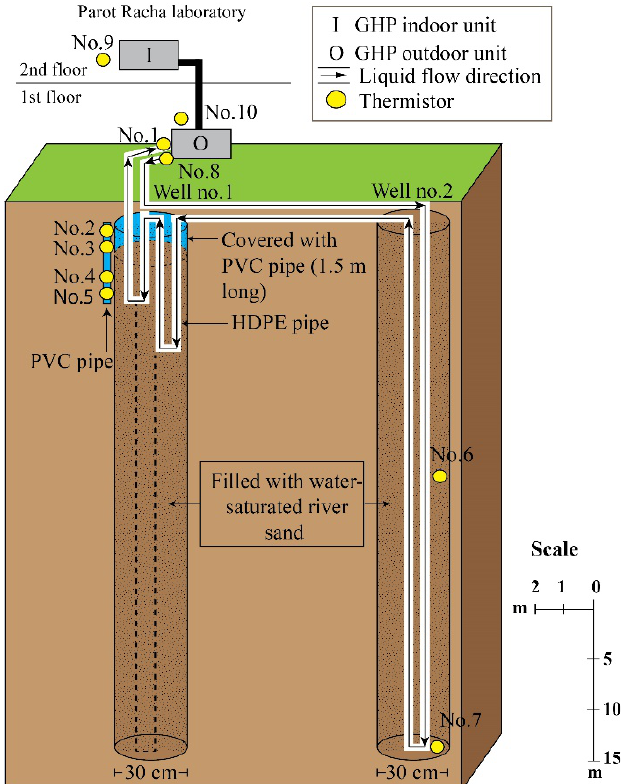
Figure 5. Schematic installation of geothermal heat pump system at Parot Racha laboratory room. Note: HDPE pipe in well no. 1 was broken. Therefore two new HDPE pipes with the lengths of 10